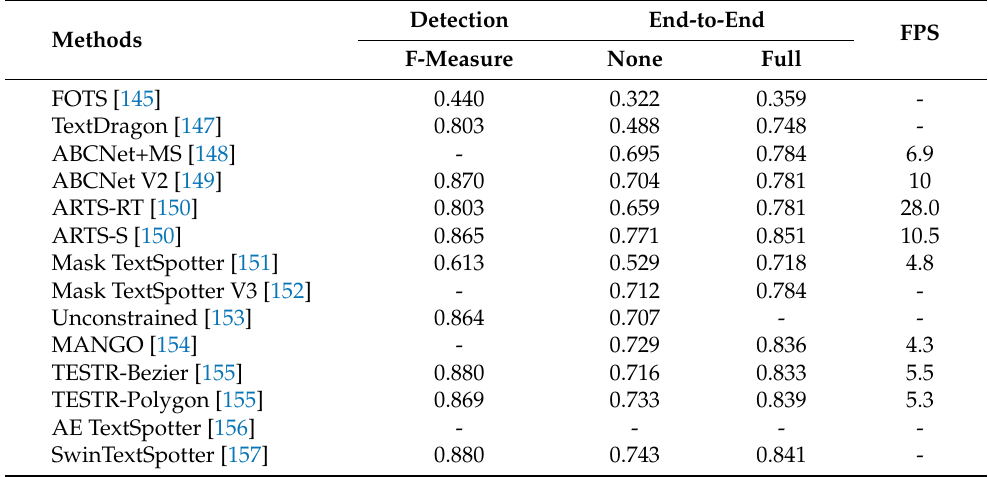
Table 10. Comparison of end-to-end text recognition in Total-Tex dataset. For more details of the networks, please consult the respective